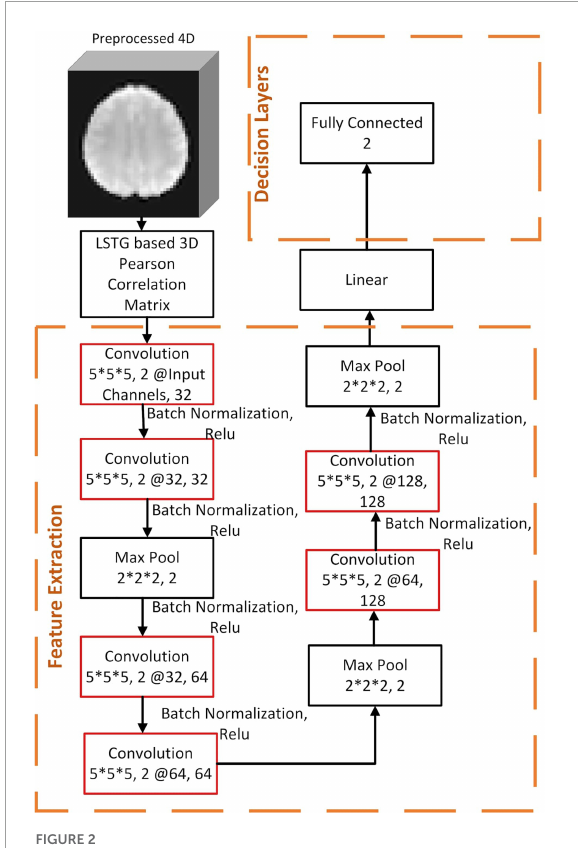
FIGURE2 Convolutional Neural Network Models for prognosis